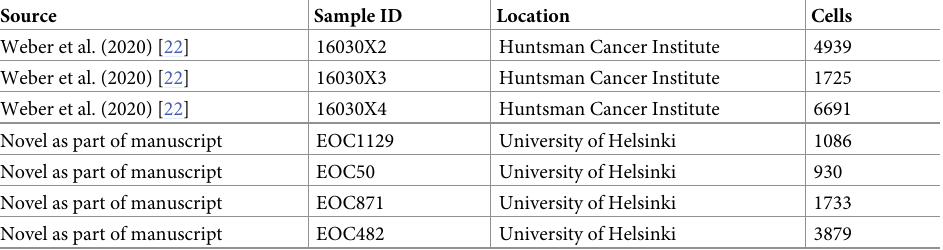
Table 2. Description of human high-grade serous ovarian cancer (HGSOC) tissue scRNA-seq datasets. Columns from left to right include the source, the organism, the location from where the tumors were obtained, and the number of cells prior to QC in each dataset. Huntsman Cancer Institute samples were processed with the 10x Genomics 3’ Gene Expression Library Prep v3 protocol, and University of Helsinki samples were processed with Chromium Single Cell 3’ Gene Expression v2